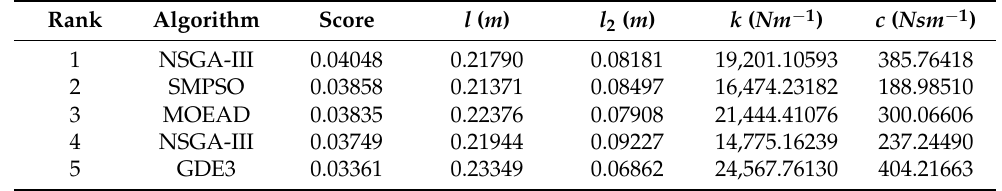
Table 4. Based on TOPSIS method, the optimal solution sets integrated by eight evolutionary algorithms were comprehensively scored, and the top five solutions are